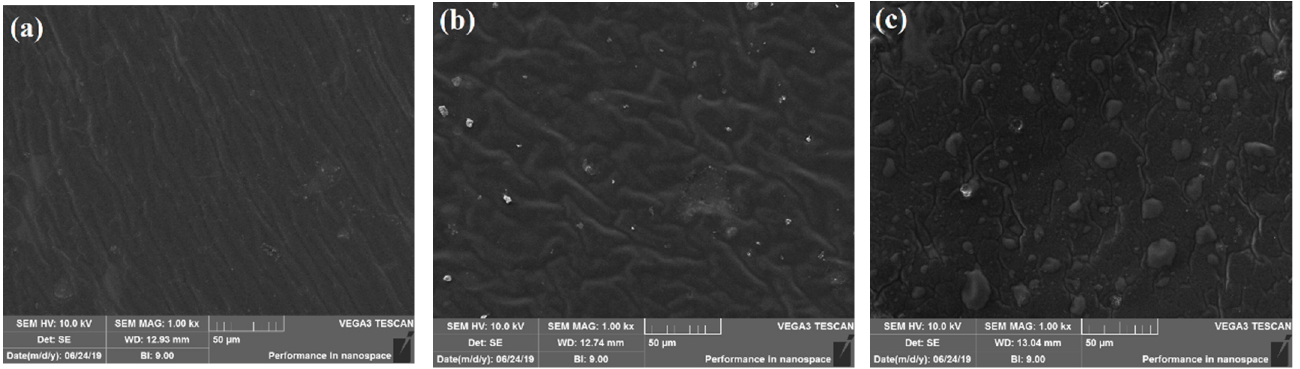
Figure 10. SEM images of ( a ) TPFPU-1, ( b ) TPFPU-4 and ( c ) TPFPU-7.